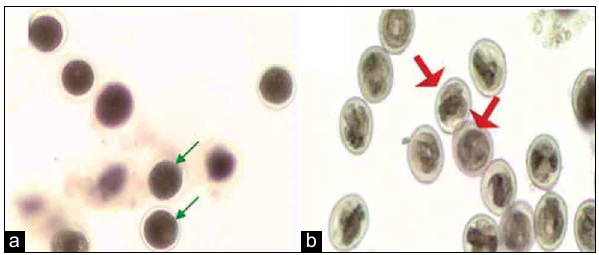
Figure-2: Light micrographs for non-embryonated egg and embryonated egg of fertilized Toxocara vitulorum egg. (a) Non-embryonated egg (green arrow) and (b) embryonated egg with larva (red arrow)